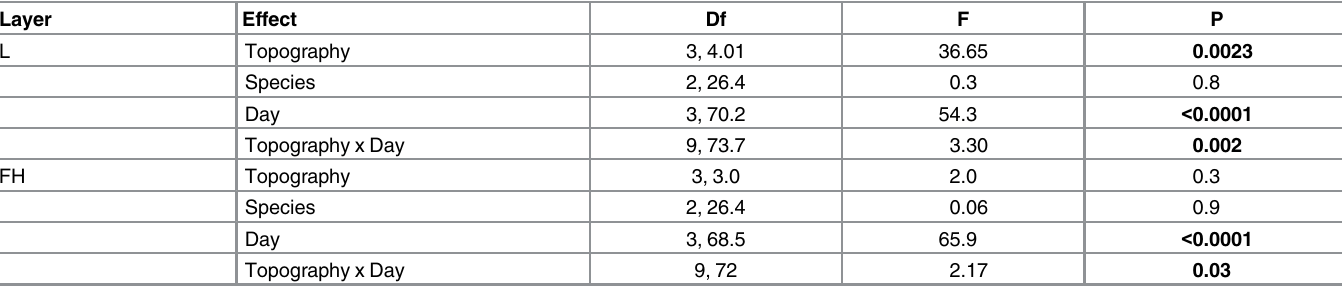
Table 4. The effects of species type, topographic setting, and day on measured fuel moisture over a 5-day dry-down in May 2010.